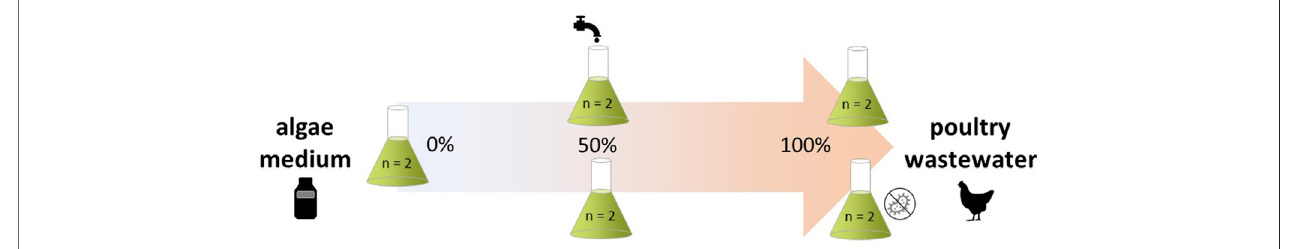
FIGURE 1 | Experimental setup to screen the microalgal growth potential on poultry wastewater dilutions. Microalgae were cultured on 100% (sterile and non- sterile) or 50% poultry wastewater (sterile), diluted either with freshwater ( A. obliquus , C. sorokiniana , C. vulgaris , D. armatus , P. kessleri ) or brackish water ( M. gaditana ) medium, or with tap water (all strains). 100% fresh/brackish medium (sterile) was included as control. All conditions were duplicated.